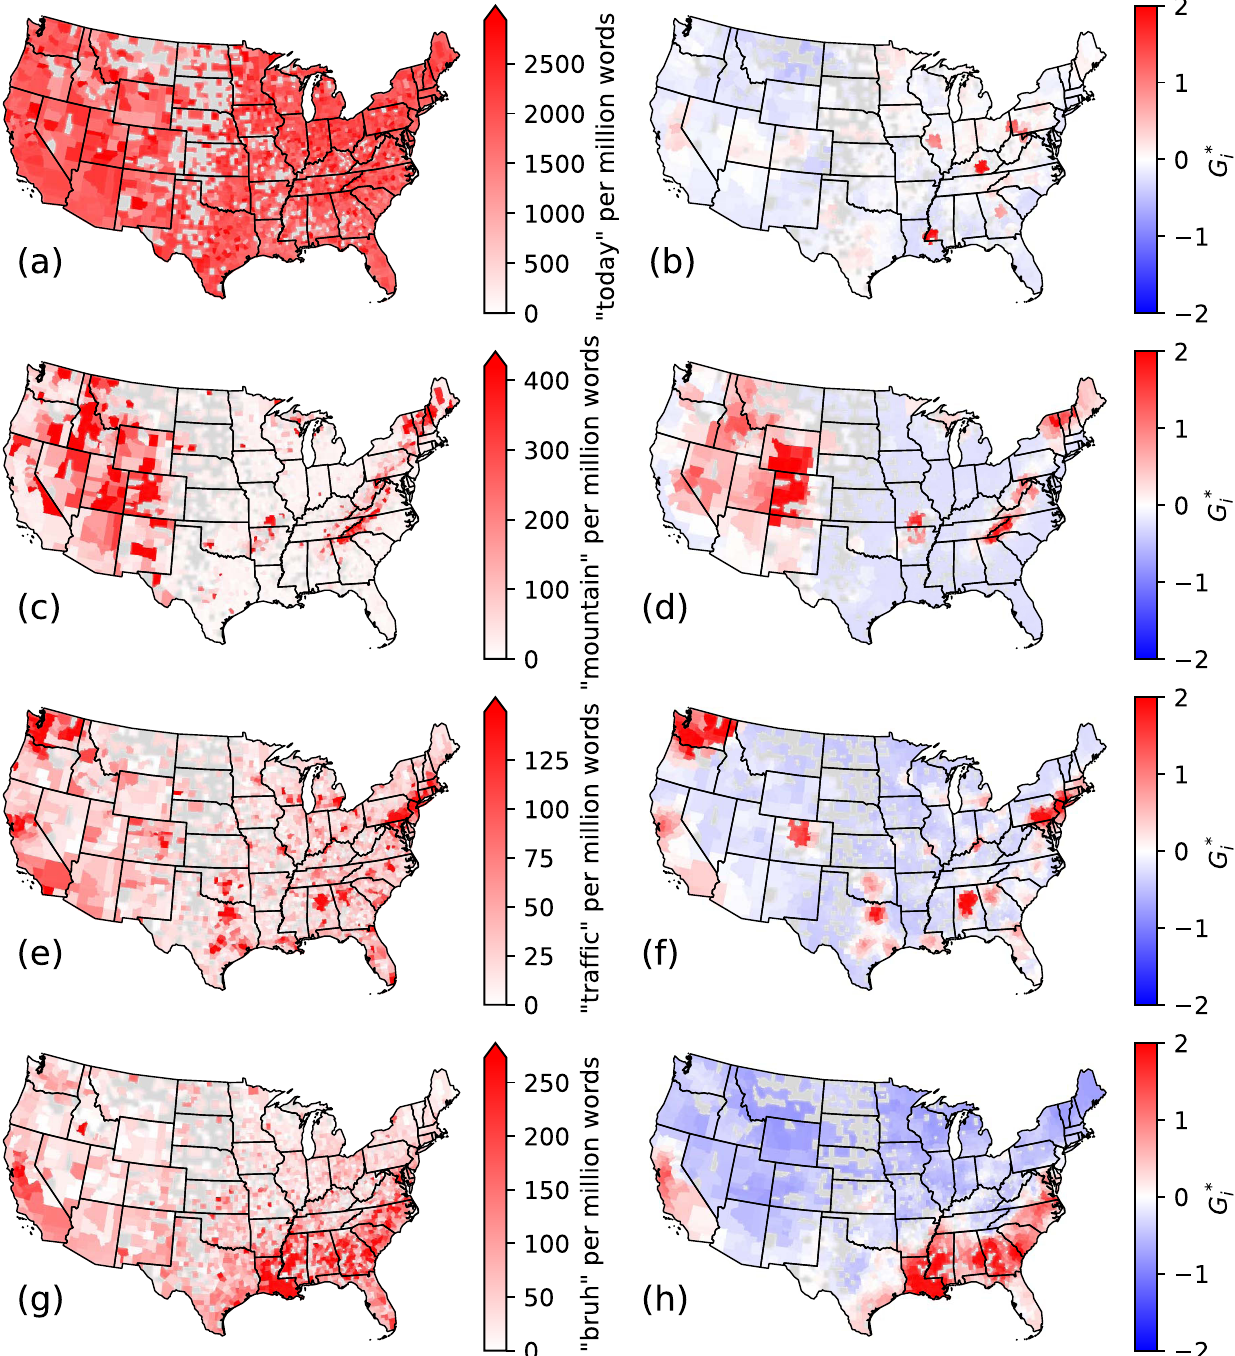
Fig. 2 Hotspots in the usage of characteristic words. Maps showing the ( a , c , e , g ) relative frequency and ( b , d , f , h ) Getis-Ord G (cid:1) i z -score for the words today , mountain , traf fi c, and bruh , respectively. One can note how the latter metric enables to reveal of word usage hotspots, smoothing out the raw noisy signal from the